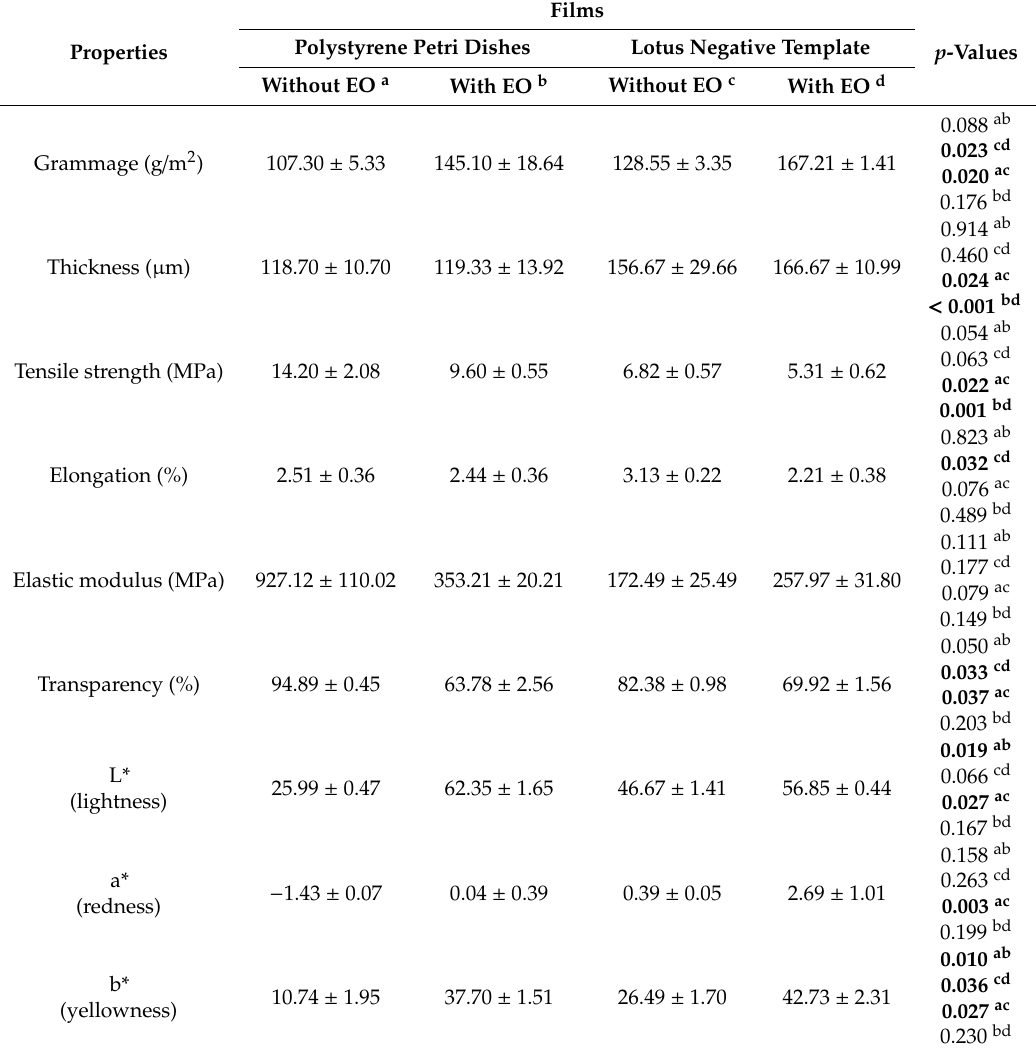
Table 1. Grammage, thickness, mechanical and optical properties of the